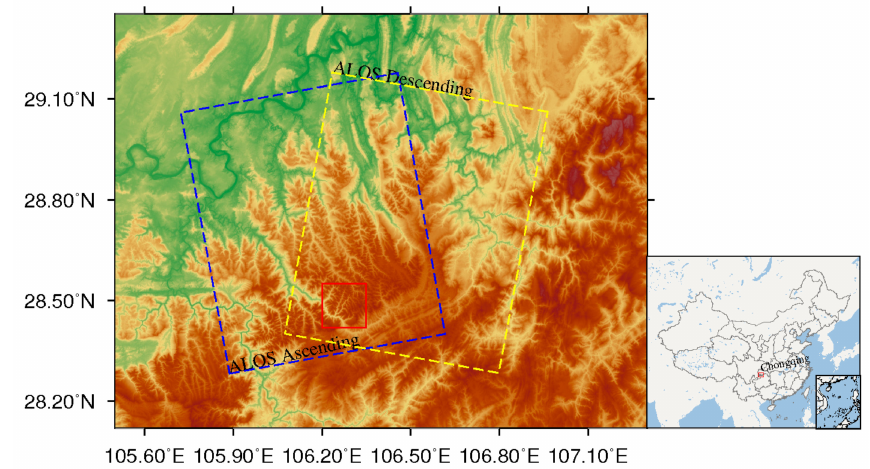
Figure 3. Shaded relief map of Chongqing. The red box indicates the scope of the study area. Blue and yellow dashed boxes indicate the coverage of the ascending and descending ALOS PALSAR datasets,